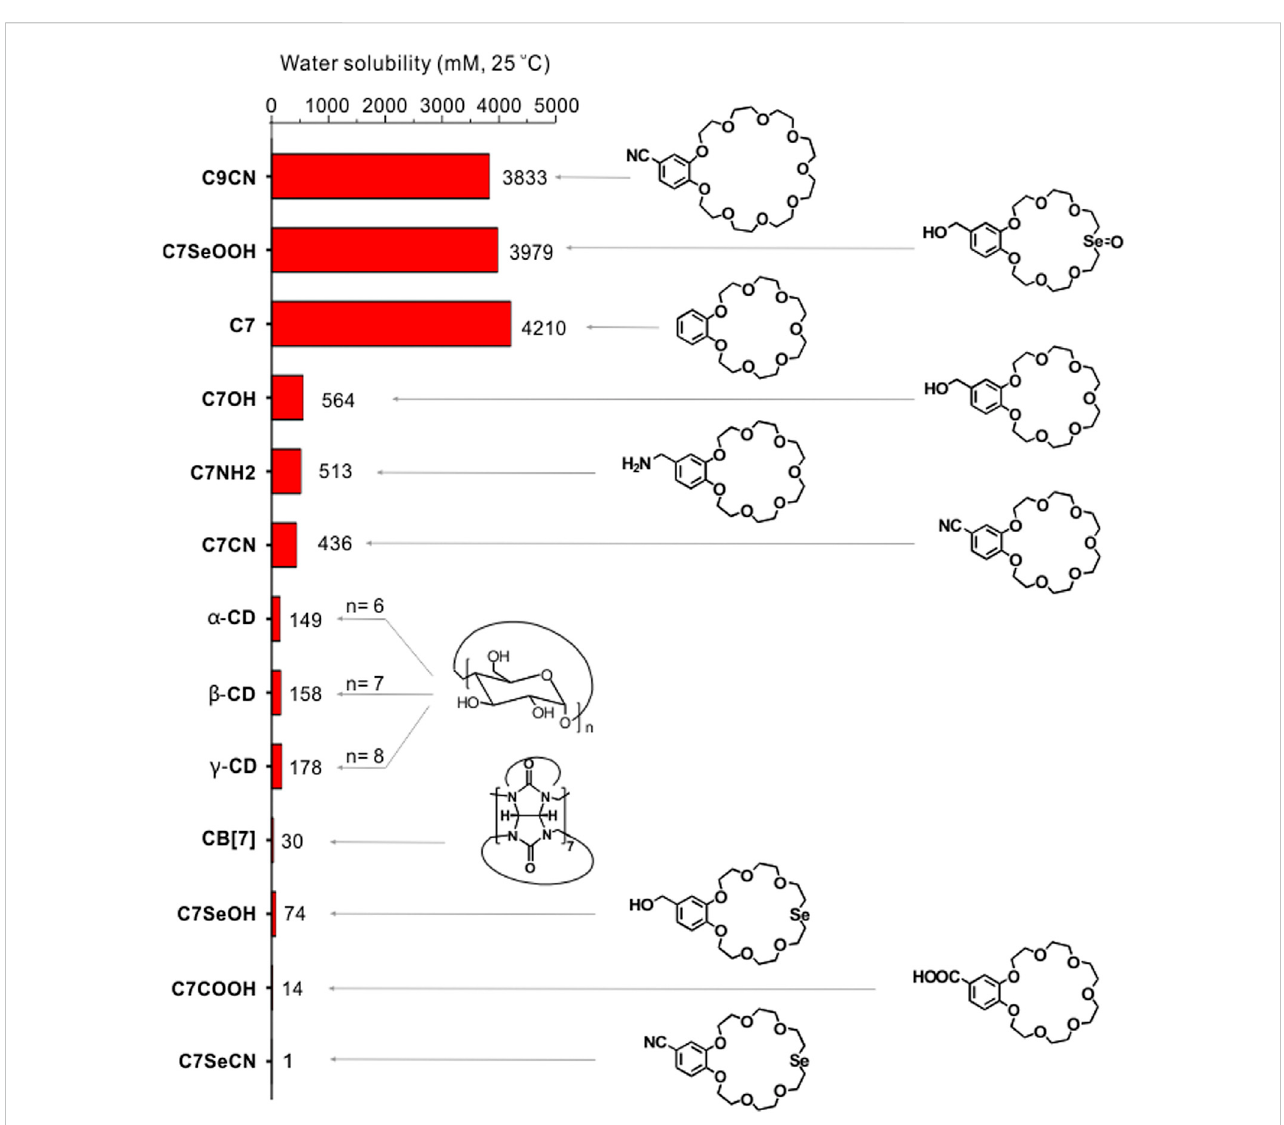
FIGURE 1 Comparison ofthewater-solubilityofCEsandtheirderivatives with α -cyclodextrin, β -cyclodextrin, and γ -cyclodextrinandcucurbit[7]urils. Adaptedand reproduced from Dong et al. (2017a), Jin et al. (2019), Xu et al. (2021) with kind permission from American Chemical Society and Elsevier.